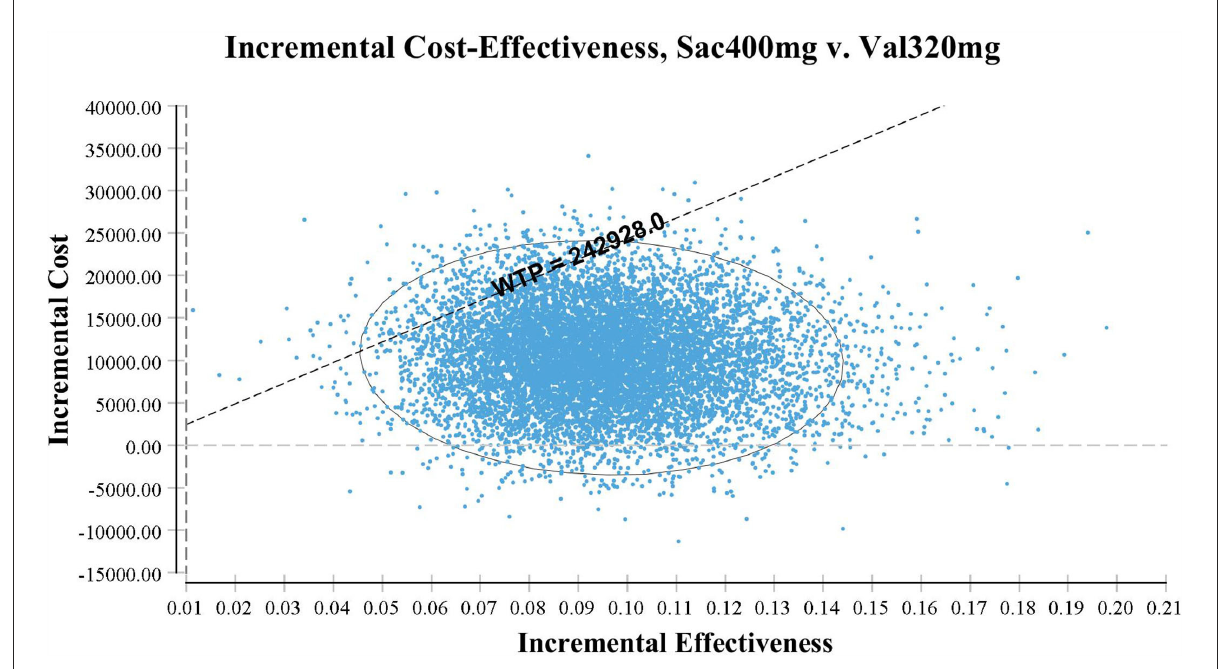
FIGURE4 Scatter plot based on probabilistic sensitive analysis. The probability that sacubitril-valsartan is cost-effective or superior to enalapril is over